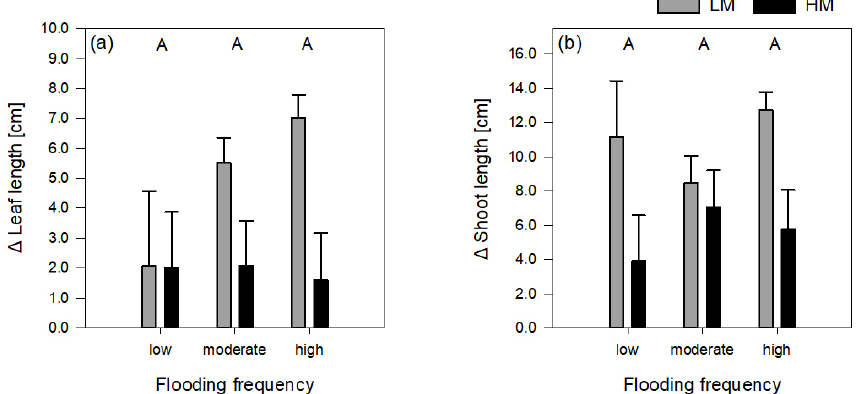
Figure 2. Delta leaf length (a) and delta shoot length (b) of both genotypes on three different flooding frequencies (mean + standard errors). Capital letters indicate significant differences between flooding frequencies. For statistics see Table 1. Table 2. Mean and standard error (SE) of rhizome length [cm], delta number of leaves and delta number of shoots for different combinations of factors genotype and flooding frequency. LM: low-marsh genotype, HM: high-marsh genotype. Rhizome length (cid:49) Number of (cid:49) Number of [cm] leaves shoots Genotype Flooding frequency N